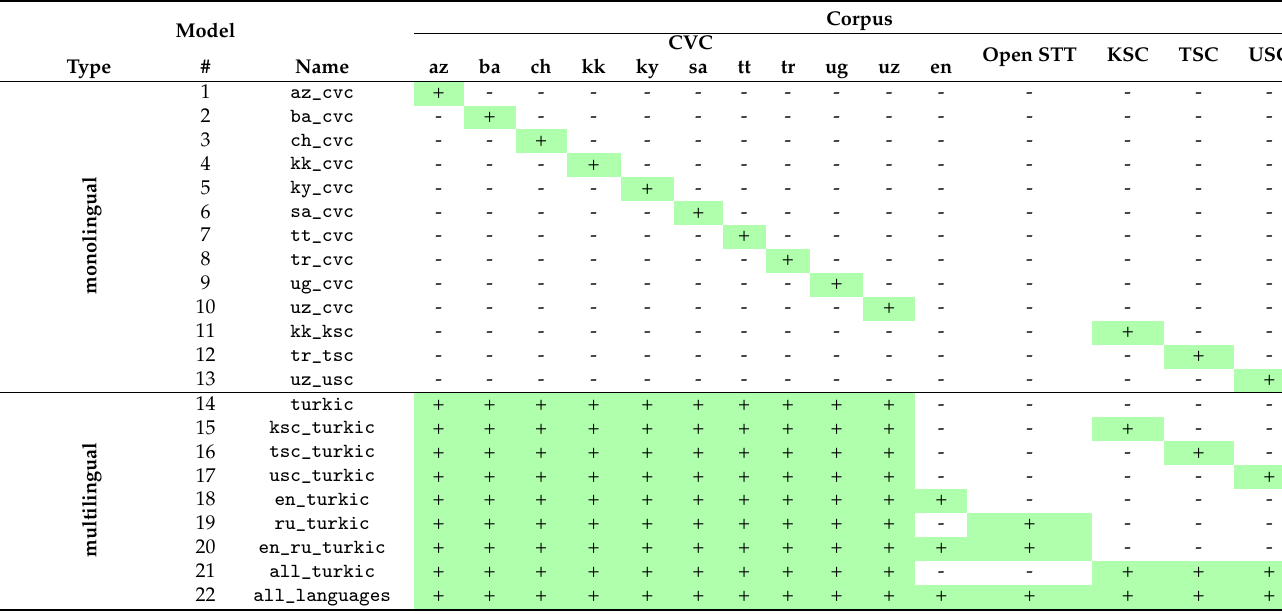
Table 5. A list of the models and the datasets used in